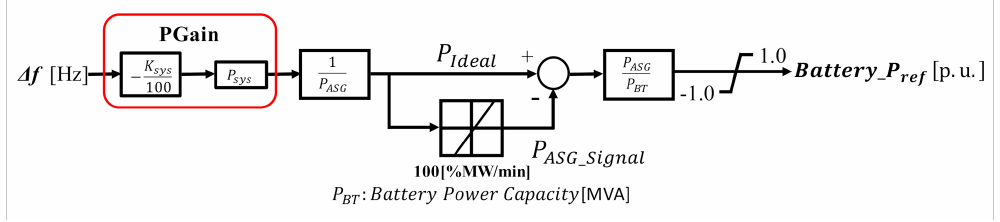
Figure 12. Frequency control system of the battery.